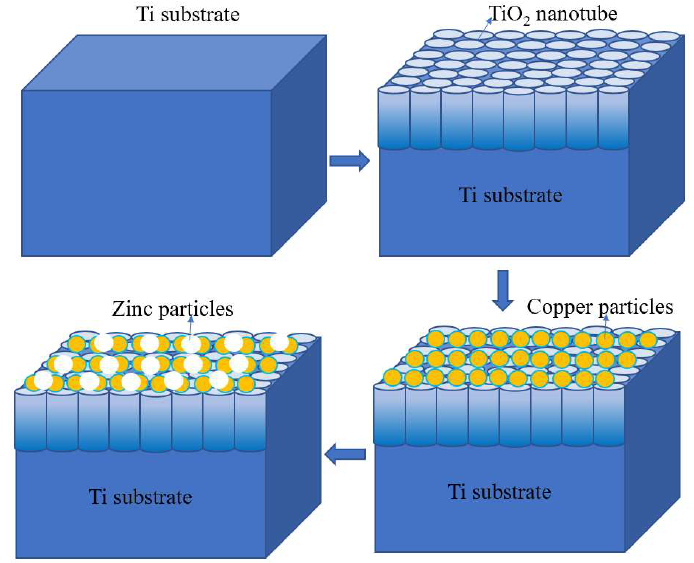
Figure 1. Schematic diagram of Zn-Cu-TiO 2 polymetallic-nanoelectrode-making process.